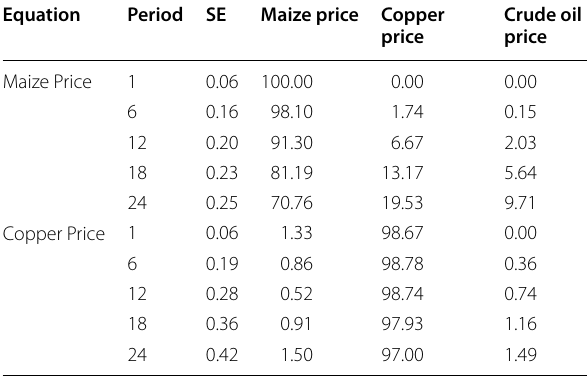
Table 11 Variance decomposition of maize and copper prices—1982 to 2021 data Equation